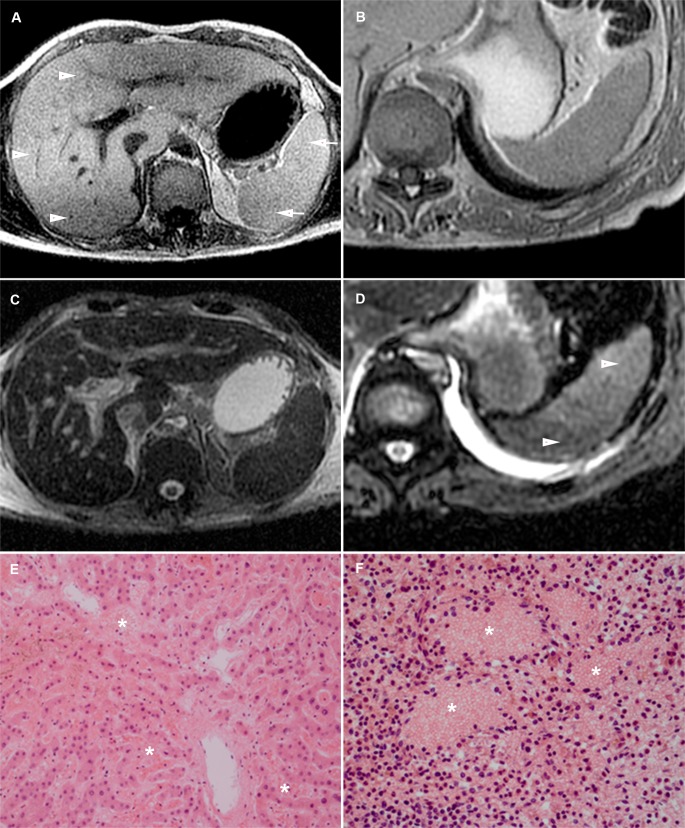
Internal livores of the liver and spleen.(A/C) T1w (A) and T2w fs (C) PMMR. Internal livores. In the liver 3 distinct layers (arrowheads) of different T1 signal can be seen and in the spleen 2 layers (arrows). A low T1 signal layer on top, relatively intermediate-to high signal layer in the middle and a low T1 signal layer in the dependent part of the liver. On T2w fs internal livores are not clearly seen. (B/D) T1w (B) and T2w fs (D) PMMR. The spleen shows 2 layers of different T2 signal (arrowheads). T1w show no clear livores in this patient. (E) HE, x100 original magnification. Centrilobular area of the liver with wide sinuses extended by blood (asterisks). (F) HE, x200 original magnification. Congested spleen with lakes of blood (asterisks).